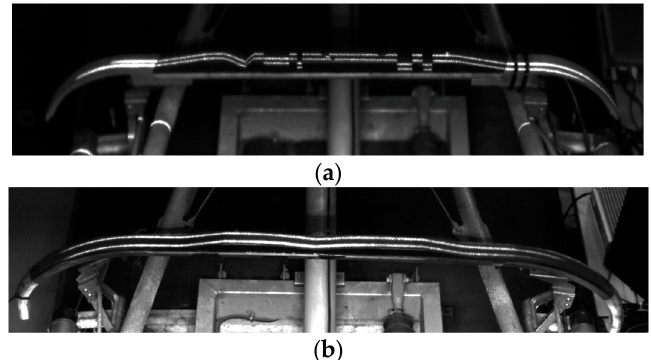
Figure 6. Images of pantograph acquired using our proposed monitoring system under ( a ) abnormal and ( b ) normal wear condition (HEUM-430x).